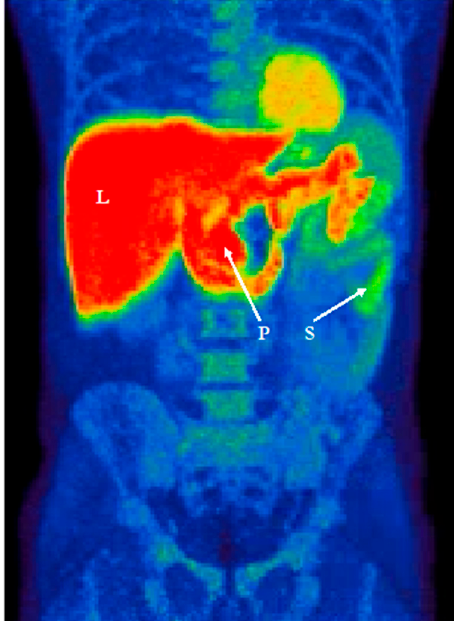
Figure 3. 11 C-Donepezil PET illustrating the summed signal of gastrointestinal organs (L liver, P pancreas, S small intestine).